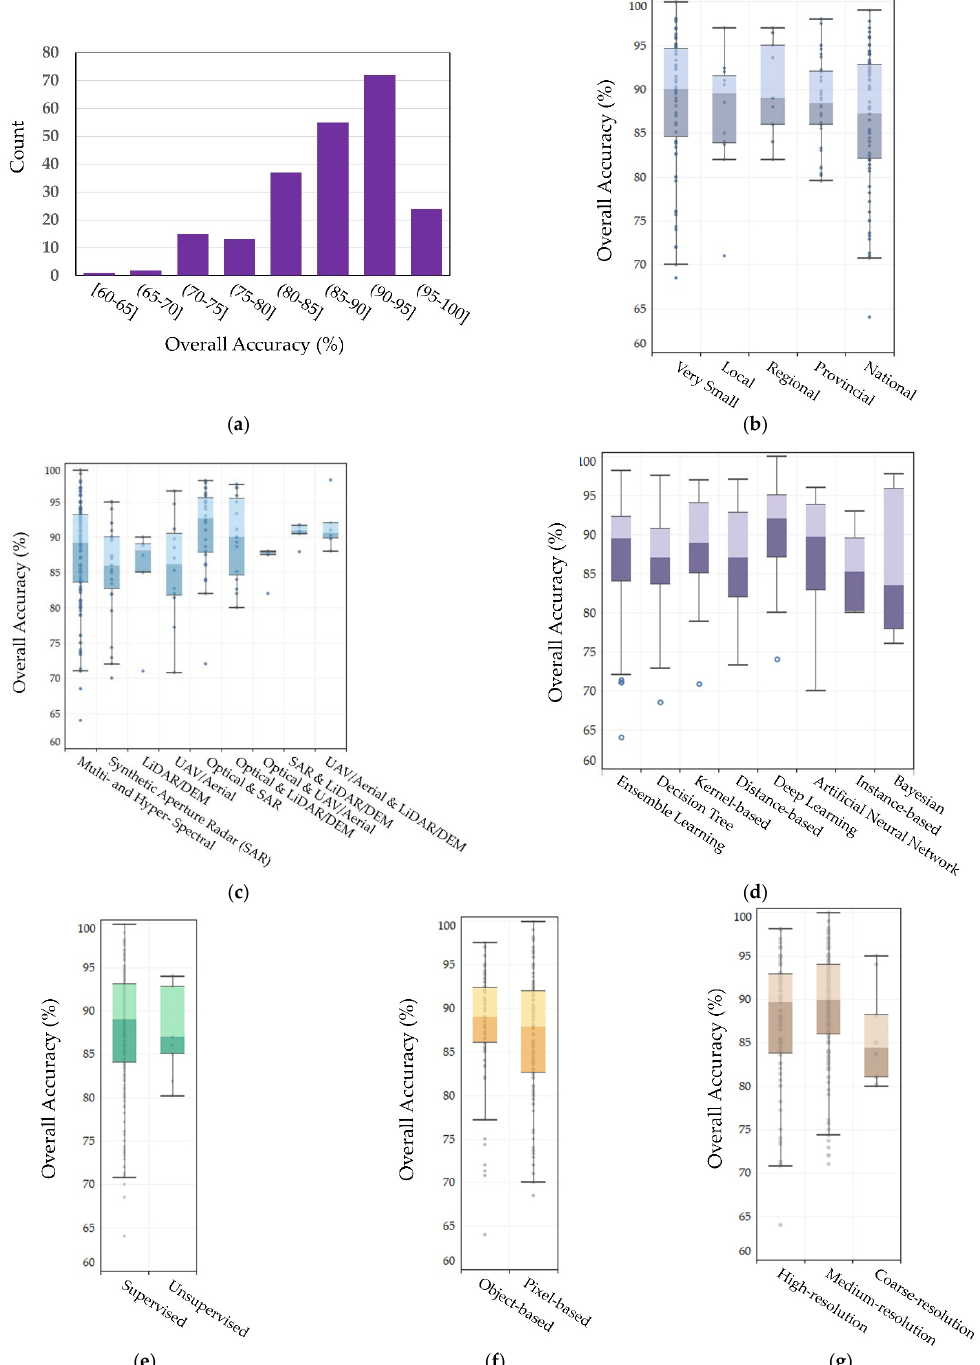
Figure 19. ( a ) The histogram of the overall accuracies reported in wetland classification papers. Box-and-whisker plots displaying the overall accuracies reported in RS-based wetland classification studies according to the ( b ) study extent, ( c ) utilized data type, ( d ) type of employed ML algorithm, ( e ) supervised or unsupervised models, ( f ) pixel-based or object-based methods, and ( g ) selected image resolution.